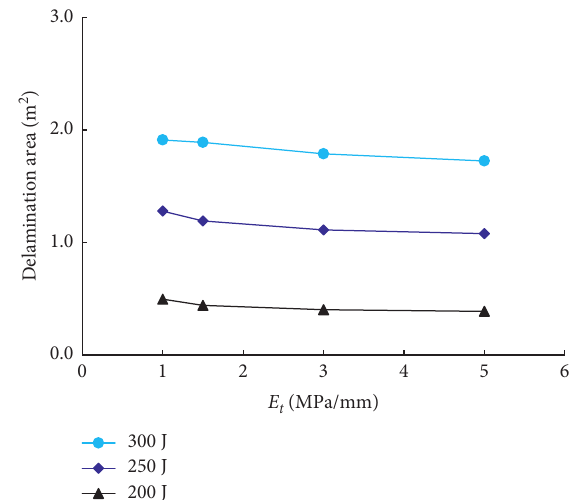
Figure 20: Distribution of the interfacial damage for the moment when the maximum vertical deformation is achieved for different E upper and bottom two panels are for the compression stage and the rebound stage, respectively. (a) E t � 1.0MPa/mm. (b) E t � 1.5 MPa/mm. (c) E t � 3.0MPa/mm.